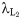
Linear and non-linear correlation networks of the number of Human Rights Violations (HR Violations), Homicide Rate (HR) per 100,000 inhabitants, Unemployment Rate, Gini Coefficient, number of gangs Ng and the leading λL and second leading λL2 eigenvalues of the adjacency matrix.For the same correlation network, left panels presents the r, ρ-values and right panels do for p-values. Only correlations satisfying r, ρ ≥ 0.6 and p ≤ 0.07 were considered.